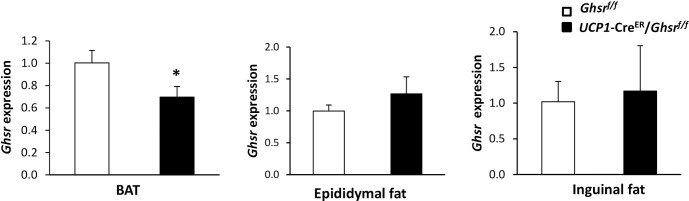
Validation of Ghsr expression in UCP1-CreER/Ghsrf/f and control mice.Ghsr mRNA expression levels in BAT, epididymal fat, and inguinal fat. All data were expressed as the mean ± SEM. n = 4‒5, *P < 0.05, Ghsrf/f
vs. UCP1-CreER/Ghsrf/f.